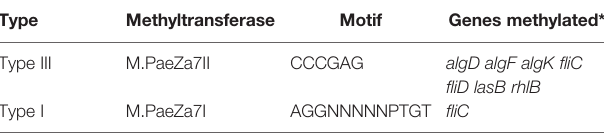
TABLE 2 | Genes methylated in LYSZa7 comparing to P. aeruginosa PAO1 and motif information. Type: type of R-M